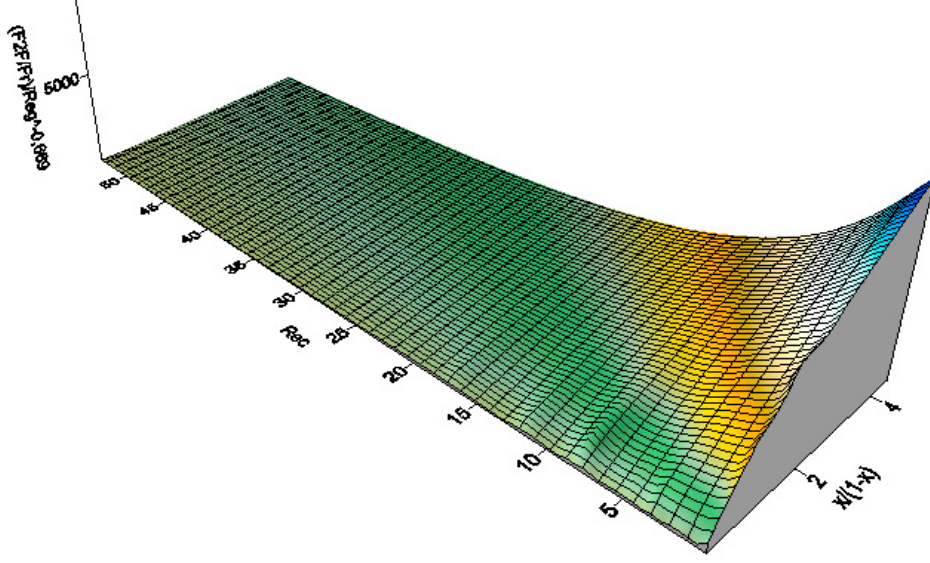
Figure 21. Representation of calculated interfacial surface based on Equation (22).